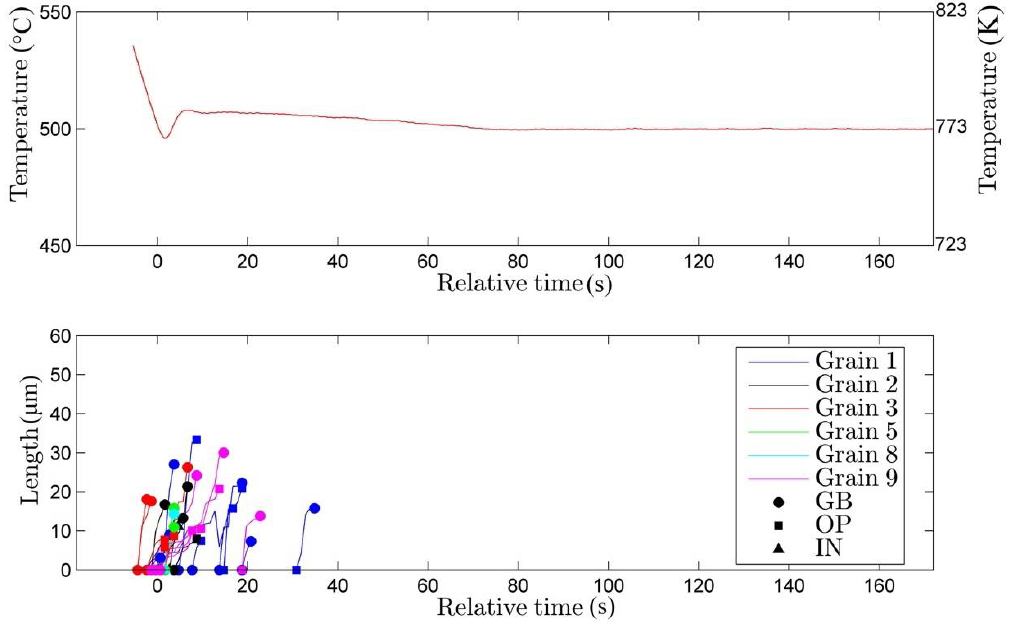
Figure 9. Temperature versus time and temporal plate growth sequence of bainitic ferrite plates in Fe-0.2C-1.5Mn-2.0Cr during isothermal holding treatment at 773 K (500 °C).